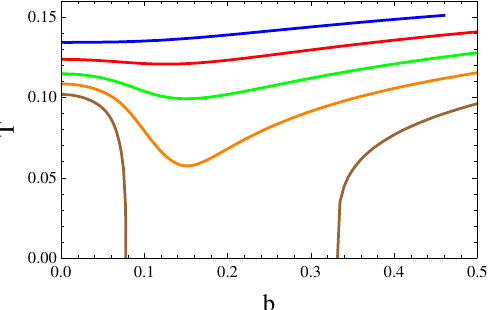
Figure 8 . Phase diagram in the ( T; b ) plane for four di(cid:11)erent values of the chemical potential: (cid:22) = 0 : 16 (blue) , (cid:22) = 0 : 2 (red), (cid:22) = 0 : 23 (green), (cid:22) = 0 : 25 (orange) and (cid:22) = 0 : 27 (brown). The blue, red, green and orange lines describe the transition from the chirally broken phase (below the line) to the chirally symmetric phase. The two brown lines describe two consecutive transitions. The (cid:12)rst transition is between the chirally broken and chirally symmetric phases (left to center) whereas the second transition turns the chirally symmetric phase into a chirally broken phase (center to